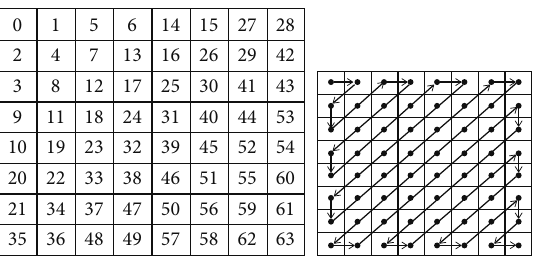
Figure 2: Zigzag mapping of the matrix.